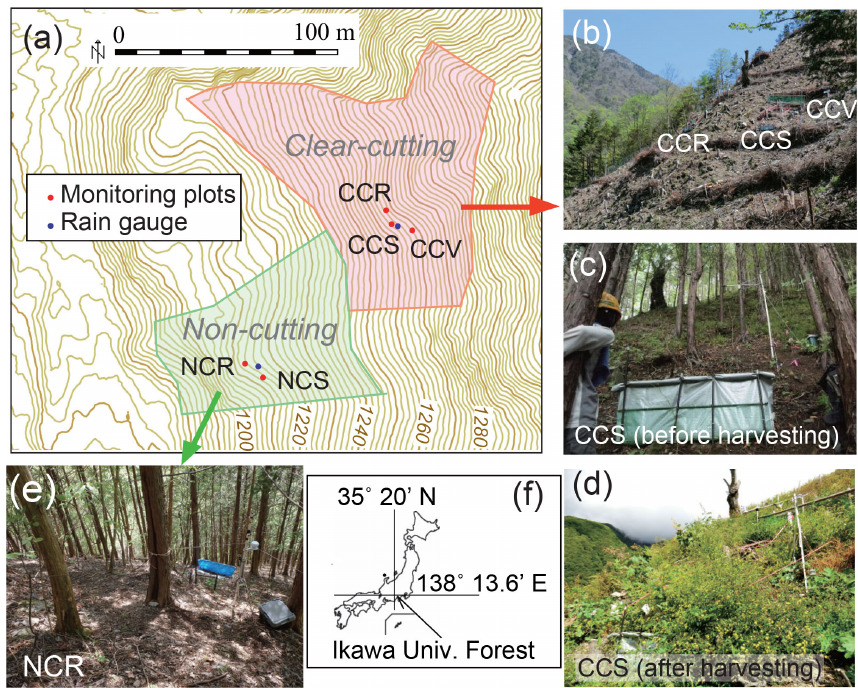
Figure 1. Topographic map and photographs showing observation sites in Ikawa University Forest. (a) Topographic map of the study site. (b) Photograph of site CC after forest harvesting (13 May 2013). Branches of harvested trees were piled up in lines parallel to the contour lines. (c) Photograph of plot CCS before forest harvesting (26 August 2011). The synthetic sheet at the lower end is the sediment trap. A radiometer was attached to the horizontal metal pipe extending from a white vertical pole on the right side of the image. (d) Pho- tograph of plot CCS after forest harvesting (26 September 2013), taken from the same location as Fig. 1c. (e) Photograph of plot NCR (14 May 2015). (f) Location of Ikawa University Forest within Japan.